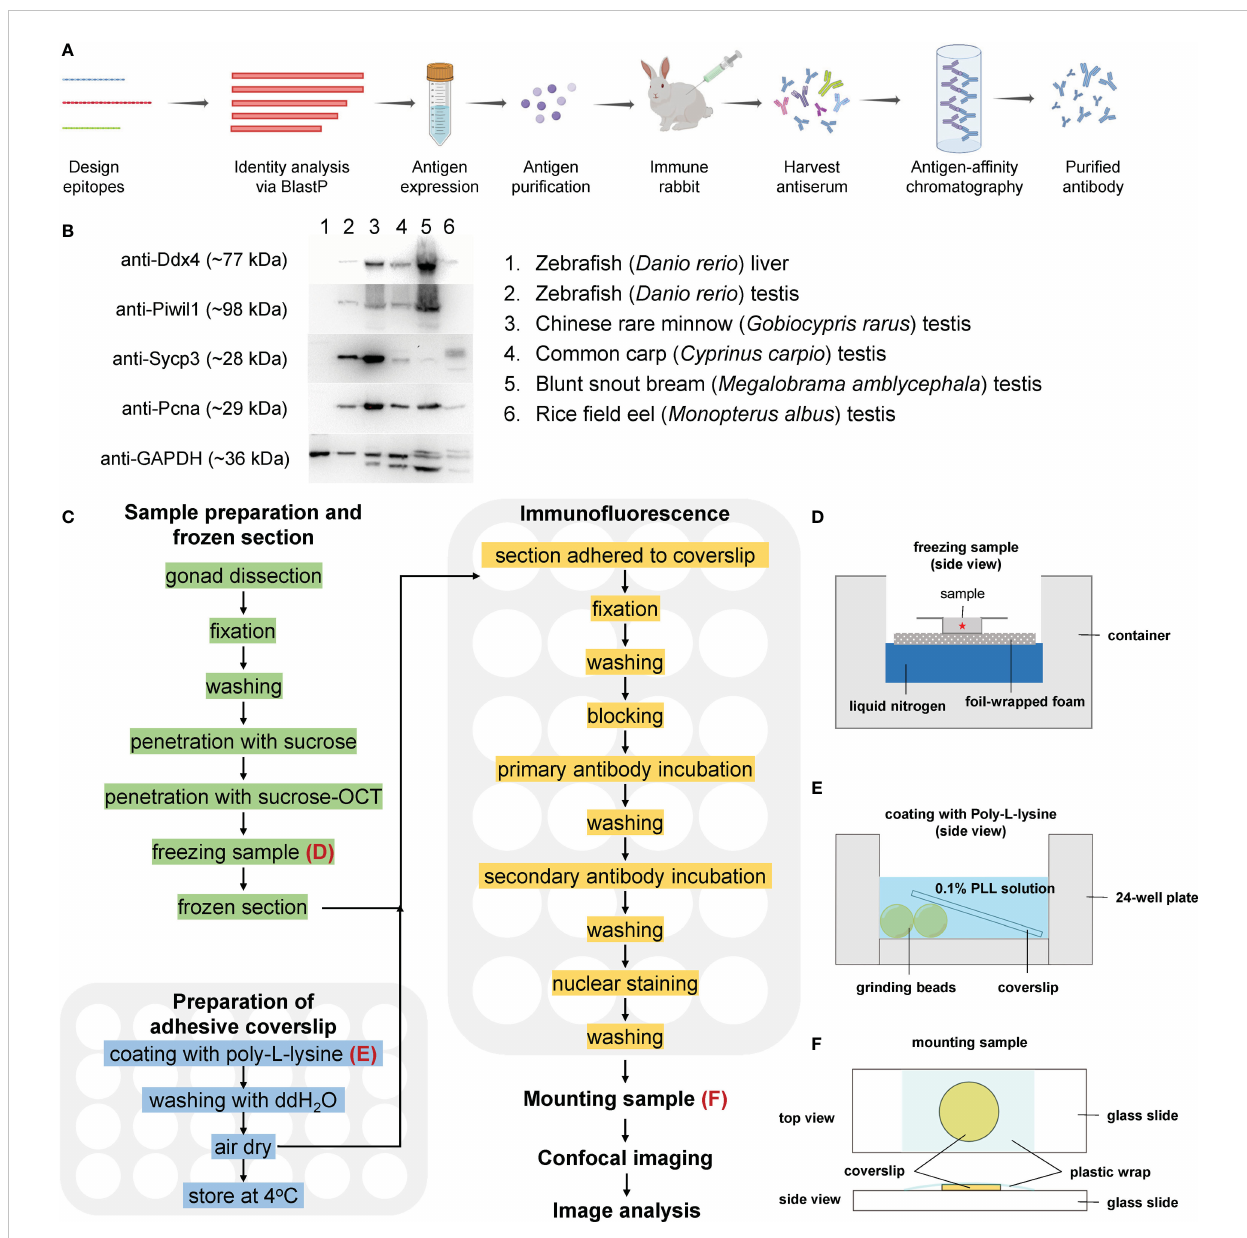
FIGURE 1 A simpli fi ed work fl ow and validation of antibodies by Western blot. (A) A simpli fi ed fl ow chart of antibody preparation. (B) Validation of the antibodies by Western blot. (C) Route diagram of the experimental procedures; the preparation of adhesive coverslips and immuno fl uorescence are performed in 24-well plates; (D) The schematic showing freezing sample in OCT; (E) The schematic showing coating with PLL; (F) The schematic showing mounting